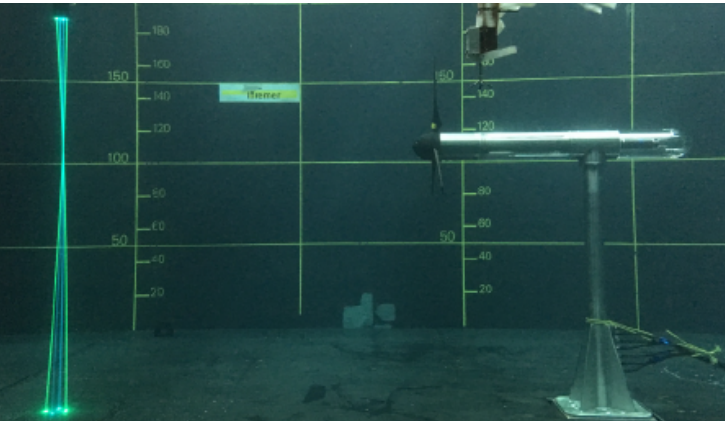
Figure 1. Side view of the three-bladed instrumented turbine in the wave and current flume tank of I FREMER